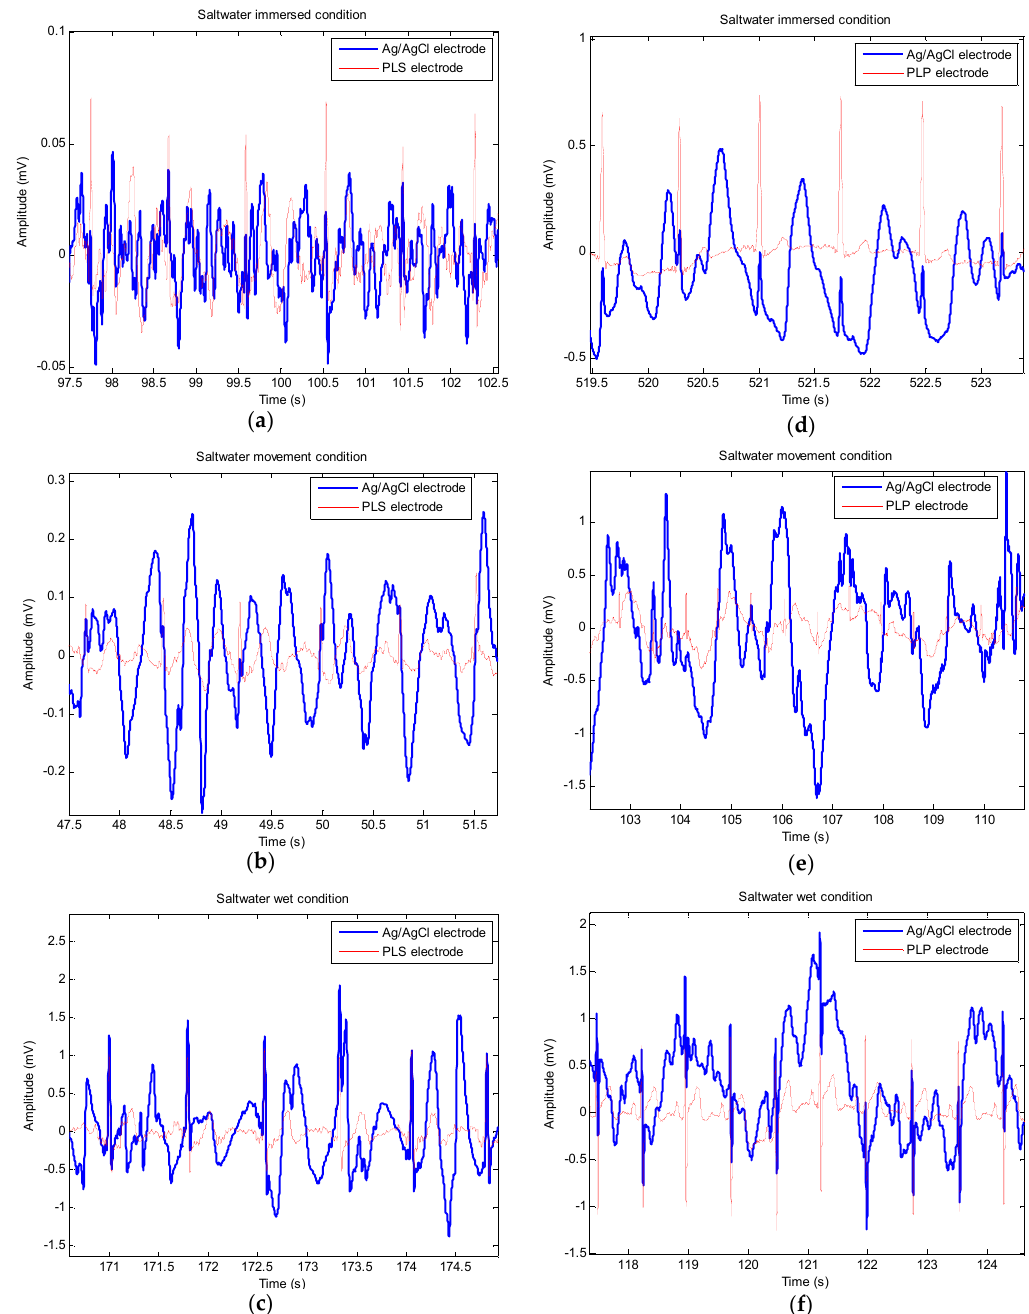
Figure 10. Example of electrocardiogram signals for each experimental condition. ( a – c ) Pencil lead solid-type electrode compared with Ag/AgCl electrode; ( d – f ) Pencil lead powder-type electrode compared with Ag/AgCl electrode; Saltwater immersed condition: ( a , d ) without movement; and ( b , e ) with movement; ( c,f ) Saltwater wet condition.